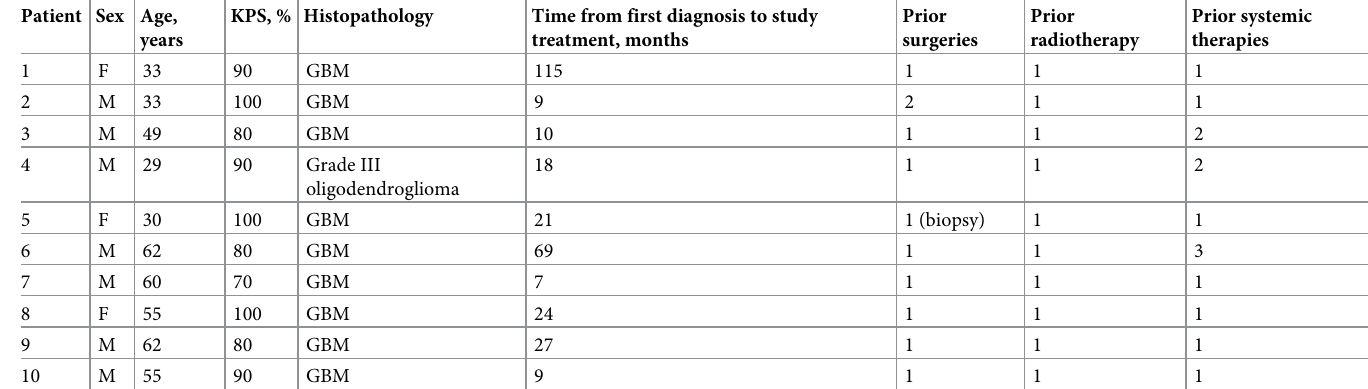
Table 1. Patient demographics and clinical characteristics at trial enrollment.